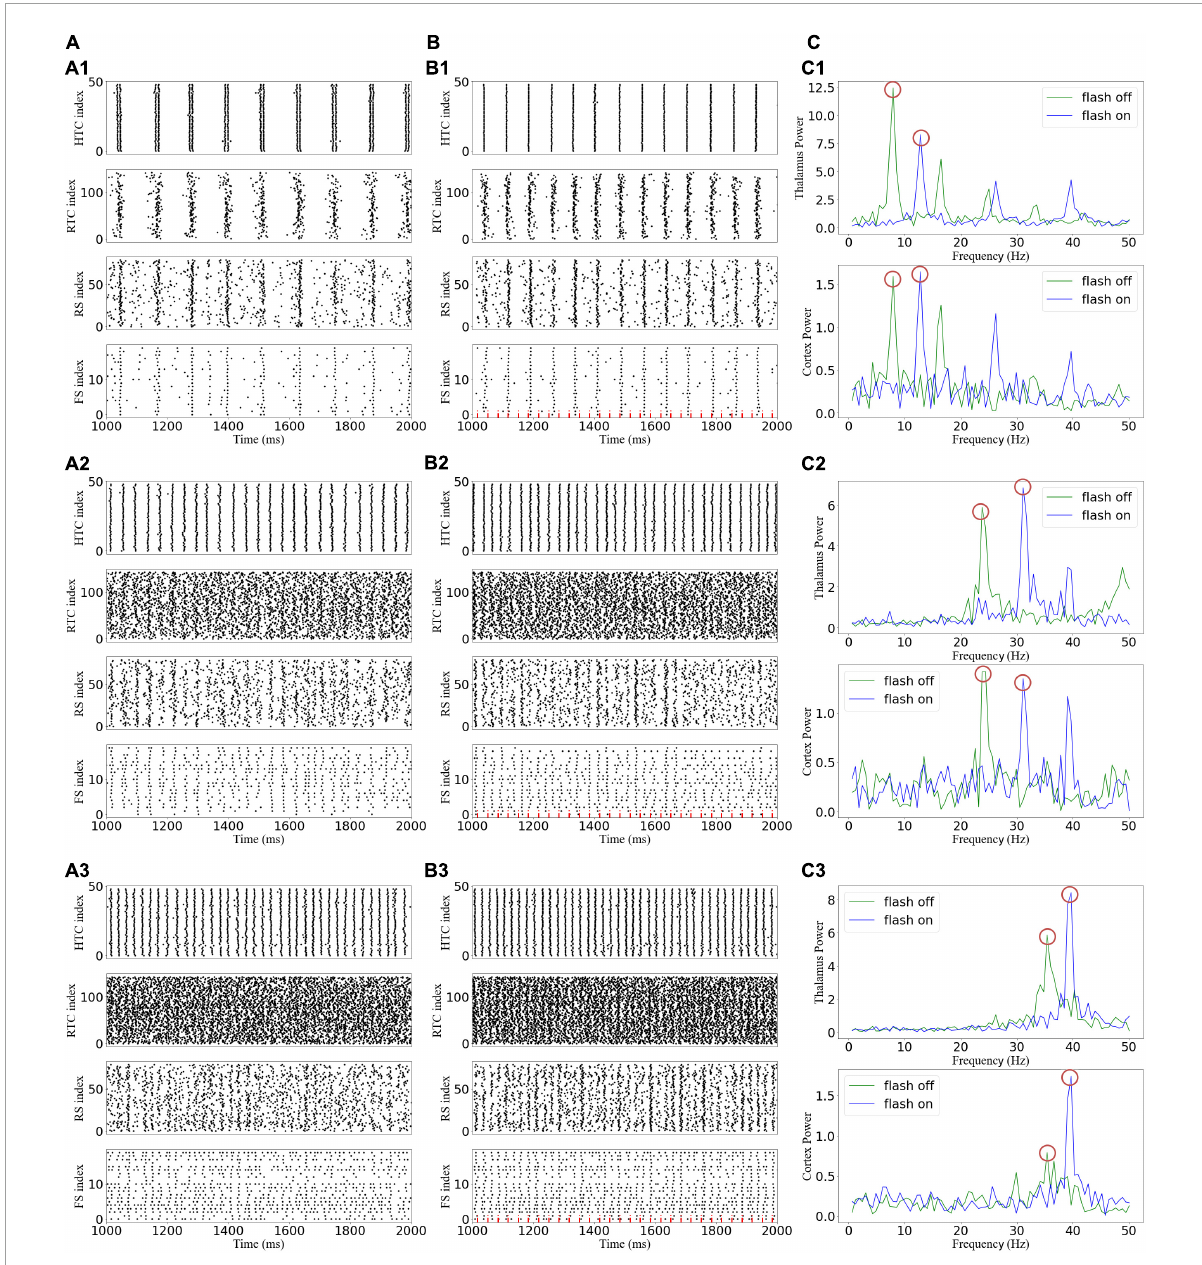
FIGURE5 Effects of gamma (40 Hz) flicker on the TC network oscillatory state. (A) Spike rastergrams of HTC, RTC, RS, and FS cells before flicker stimulation: (A1–A3) alpha, beta, and gamma oscillatory states, respectively. (B) Spike rastergrams of HTC, RTC, RS, and FS cells under flicker stimulation. The red dotted line represents incoming GC spikes. (C) Frequency power spectrum of sLFP from the thalamus (top) and cortex (bottom). The red circles indicate the main oscillation